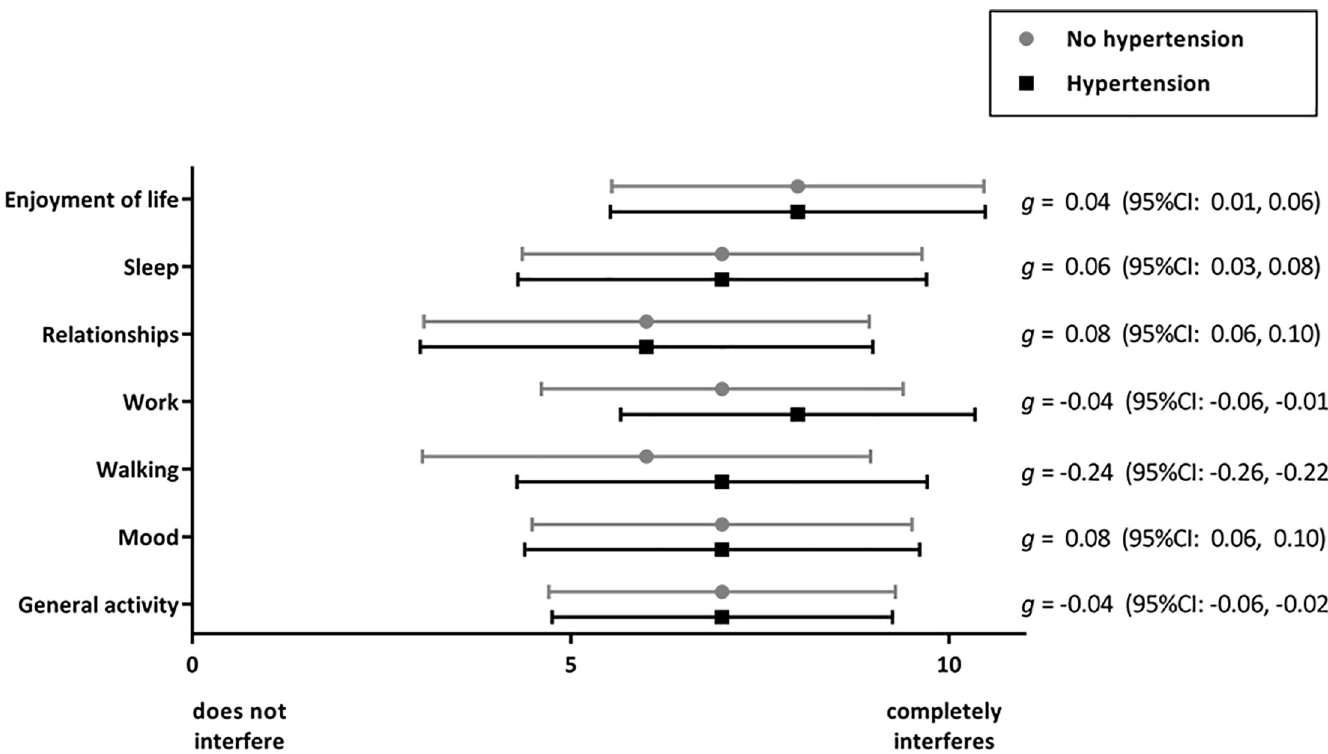
Fig 3. Mean (standard deviation) levels of pain interference between patients with hypertension and without hypertension, raw values are available in S2 Table.